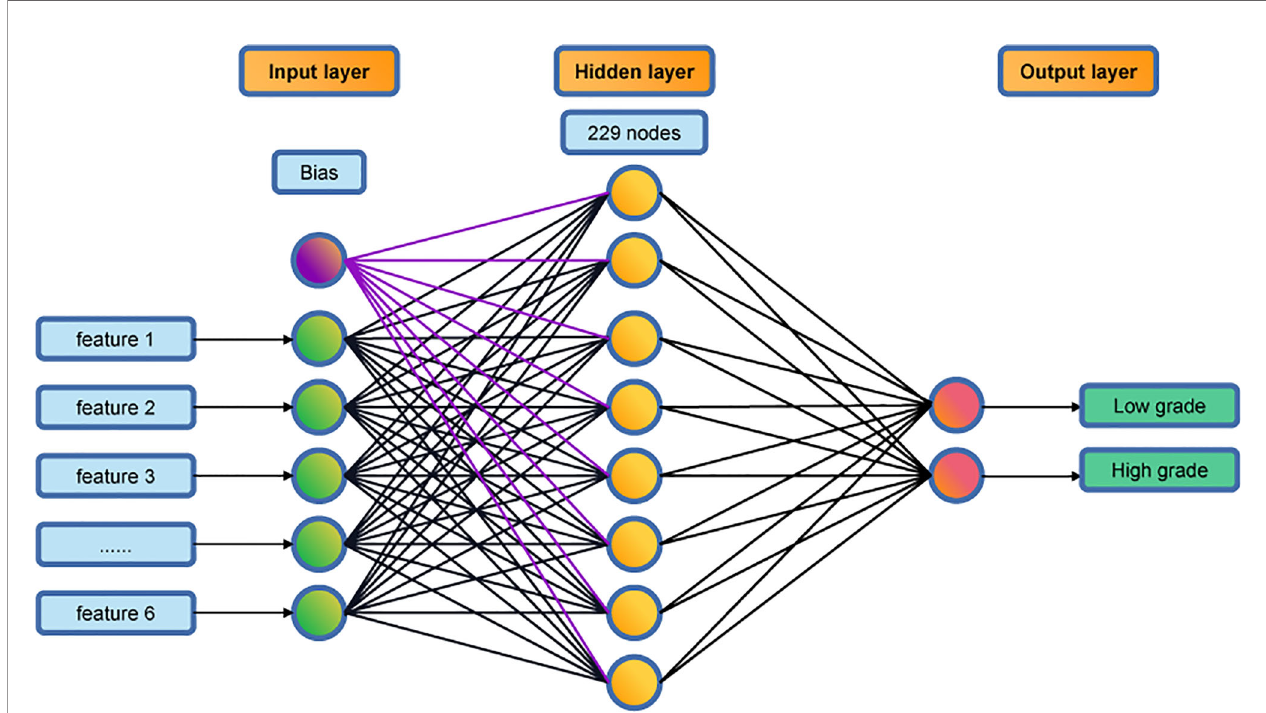
FIGURE 2 | The topological structure of the 3-layer perceptron classi fi